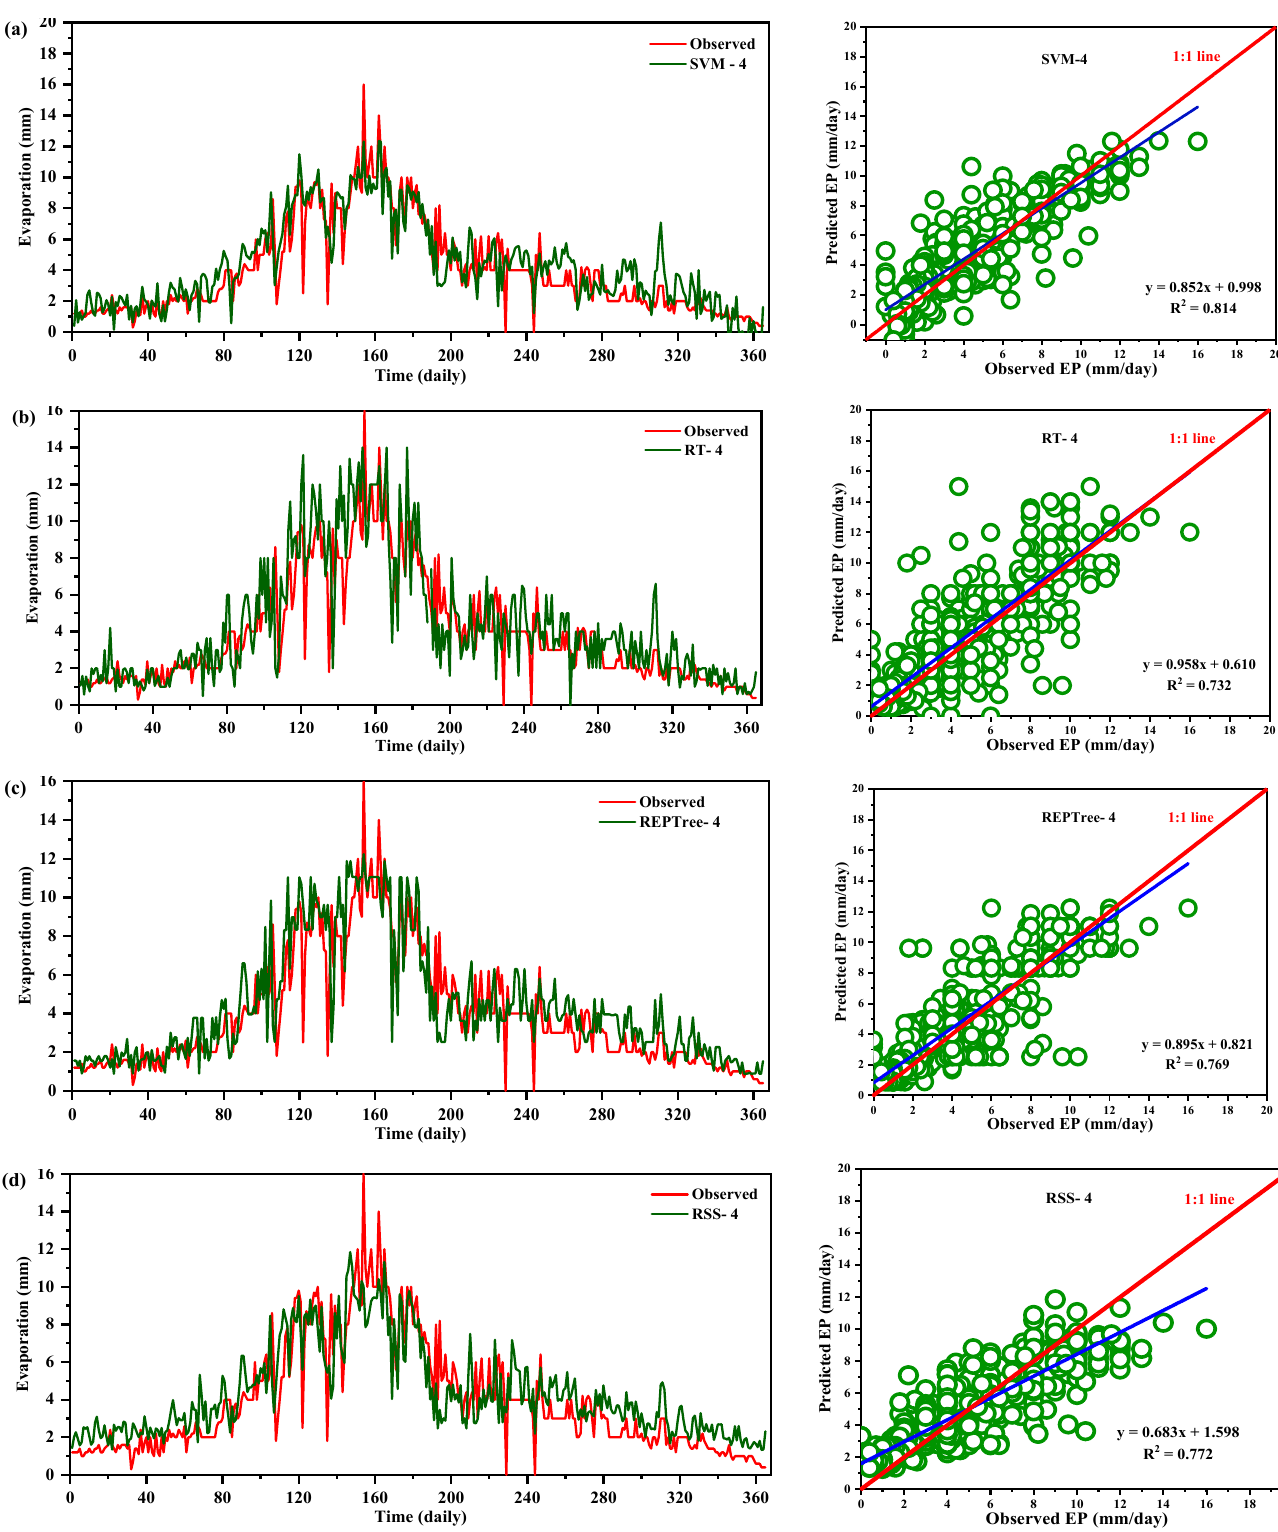
Figure 12. Sample time series plots for 2020 representing observed and modelled evaporation data (left) and scattered plots representing the entire testing dataset (right) of observed vs. estimated EP d values during testing phase at the Ludhiana station for ( a ) SVM-4, ( b ) RT-4, ( c ) REPTree-4, and ( d ) RSS-4.